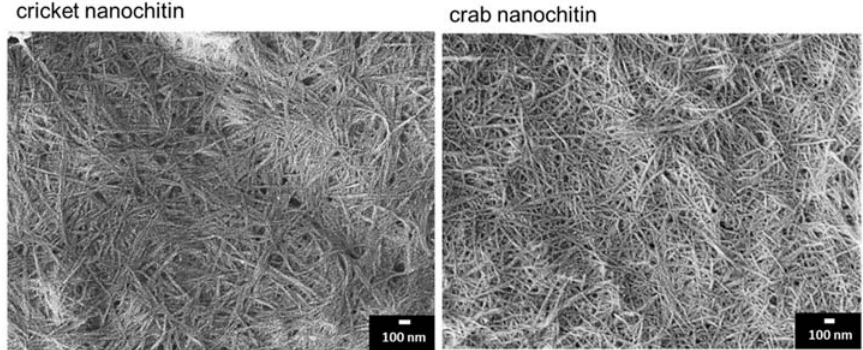
Figure 4. FE-SEM images of nanochitin from ( left ) cricket and ( right ) crab